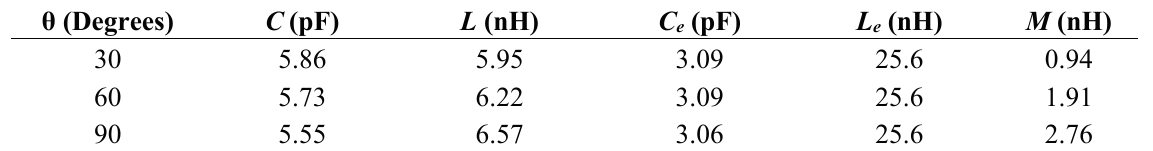
Table 1. Extracted lumped element values of the circuit of Figure 10b for the structure of Figure